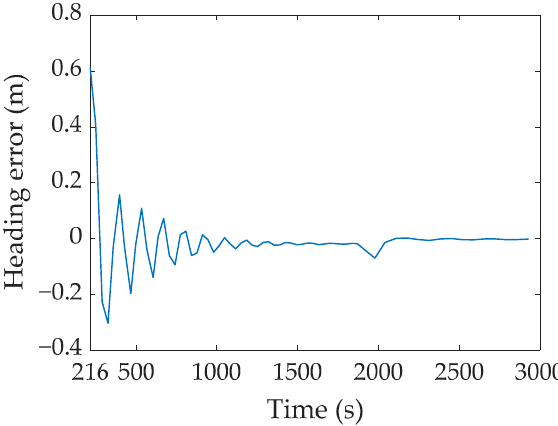
Figure 16. Cross-track heading angle error for the half-moon shape path.